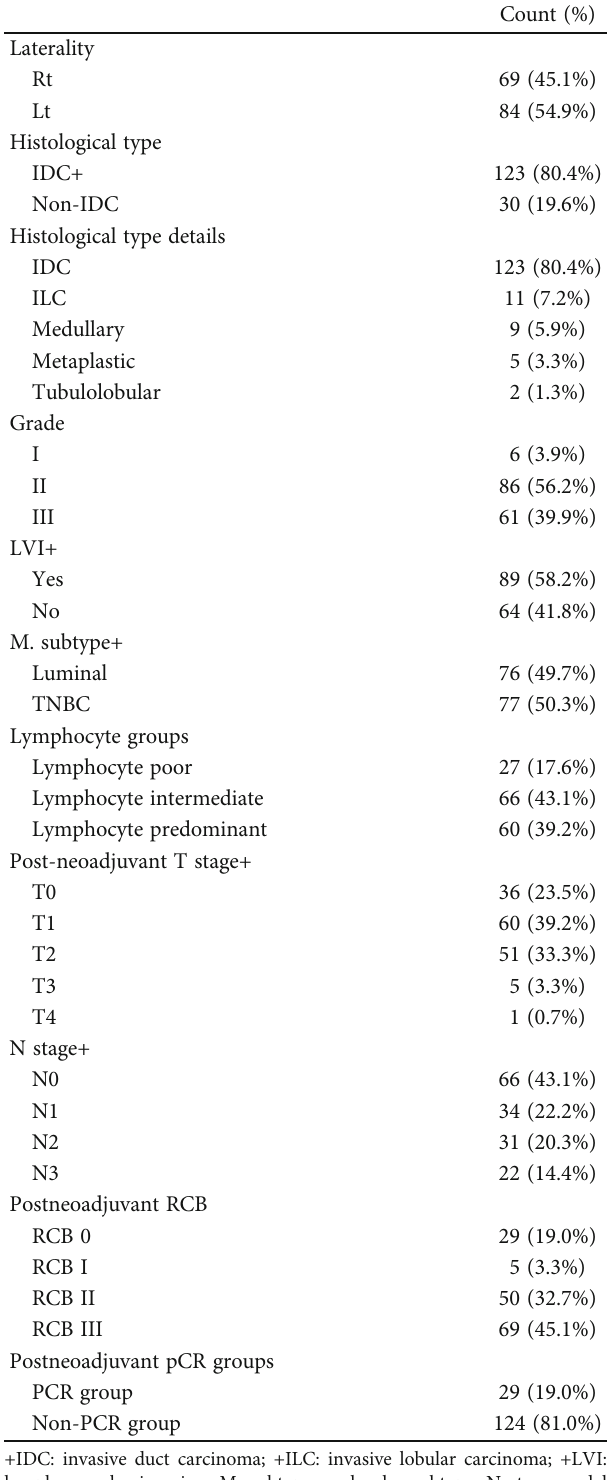
Table 1: Distribution of demographic data, pathological features collected from pretherapy core biopsies and parameters investigated in the posttherapy